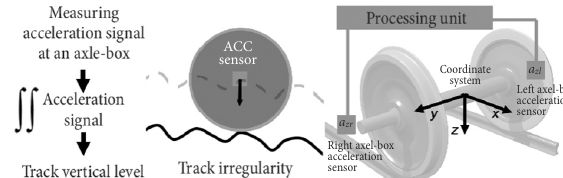
Fig. 1. Inertial track measurement at vertical level and application diagram